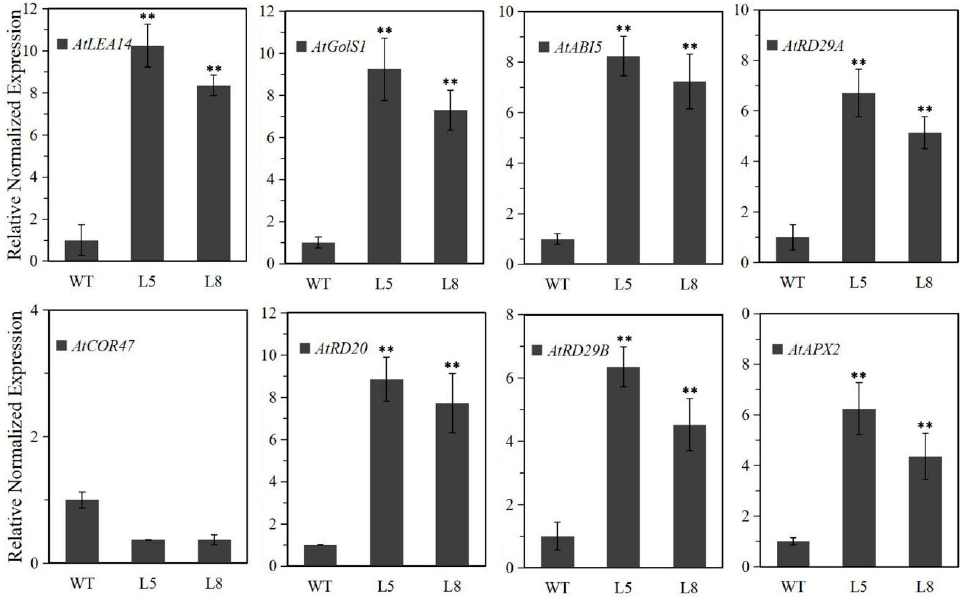
Figure 6. Expression levels of the stress-associated genes under normal condition in WT and LlMYB3 transgenic plants. Gene-specific primers were used to detect the relative transcript levels of the stress-related genes. Values are means ± SD of three replicates. Three independent experiments were performed. Asterisks indicate a significant difference (** p < 0.01) compared with the corresponding controls.